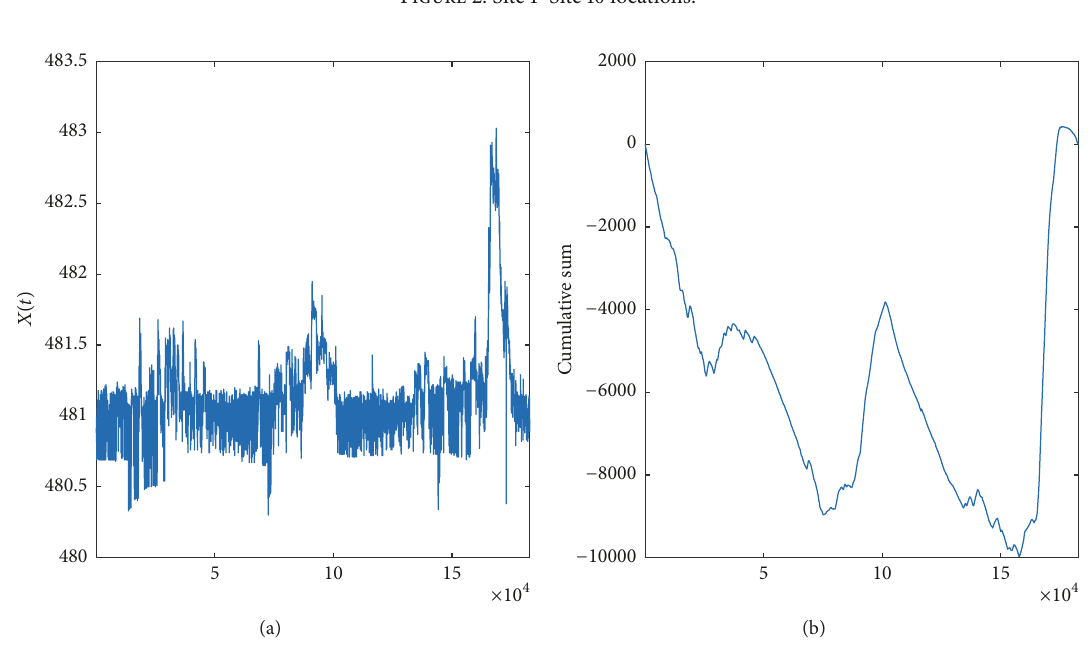
Figure 3: The water level records 𝑋(𝑡) at Site 1 (a) and the cumulative sum of 𝑋(𝑡) − 𝑋